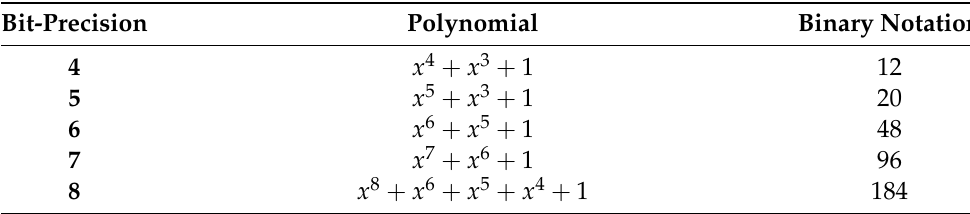
Table A2. Tap configuration used in the estimation of the best seeds.